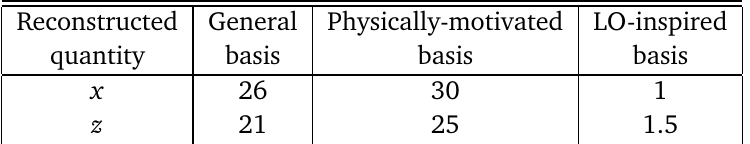
Table 1: Values of the l -parameter to reconstruct the x and z momentum fractions in three different basis used within the GR